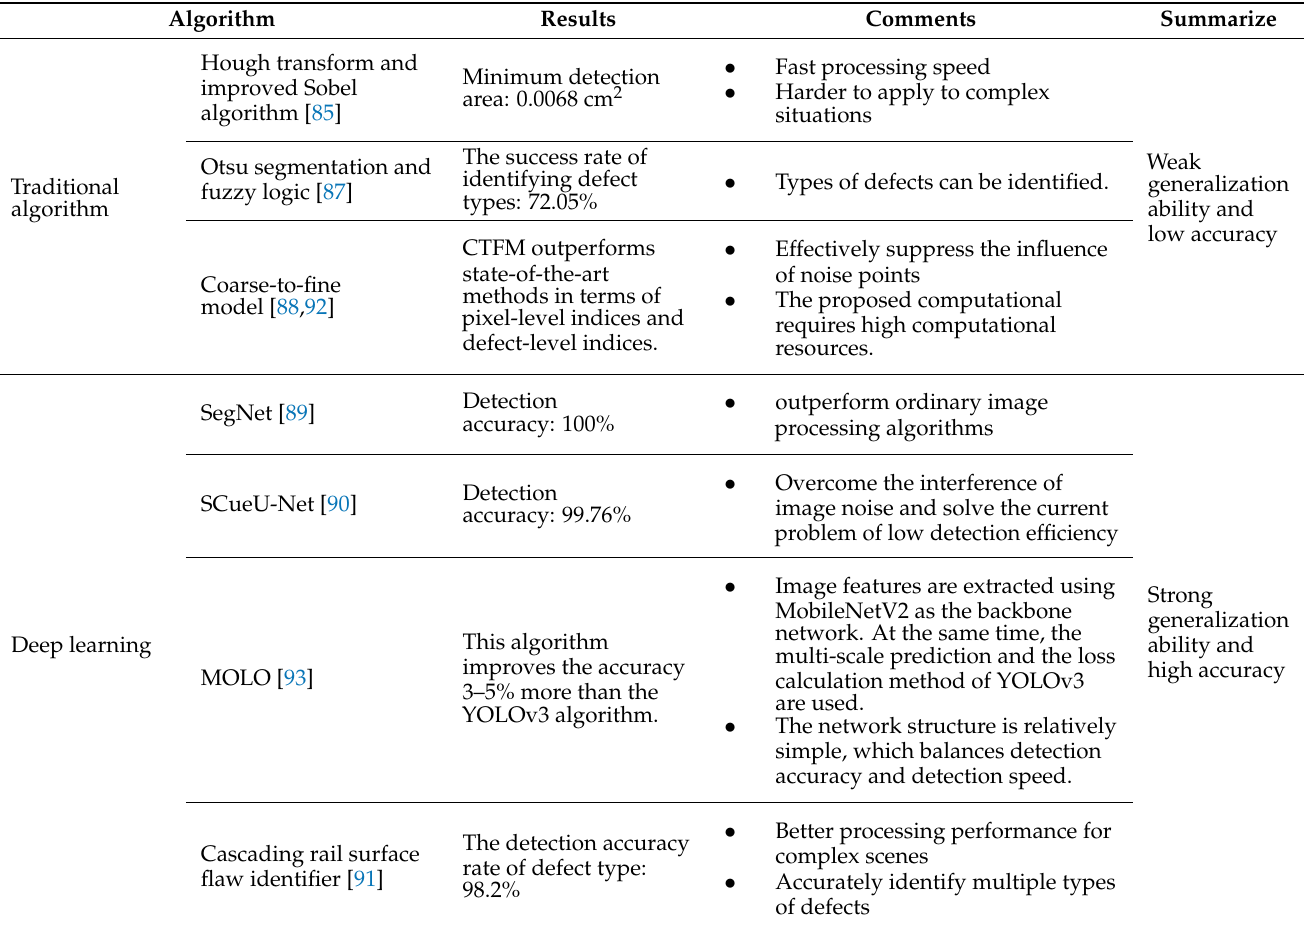
Table 6. Comparison of visual inspection